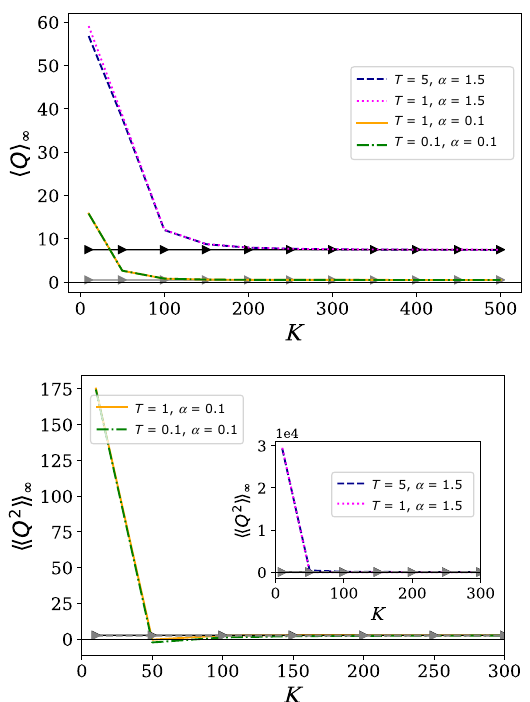
FIG. 10. Top: independent-boson model. Bottom: spin-boson model. Real (dashed line) and imaginary (solid line) parts of the characteristic function, as a function of the counting field param- eter u . We evaluated χ( u ) for both a small time t = 1 (blue) and equilibrium times t = 10 for the IB model and t = 9.53